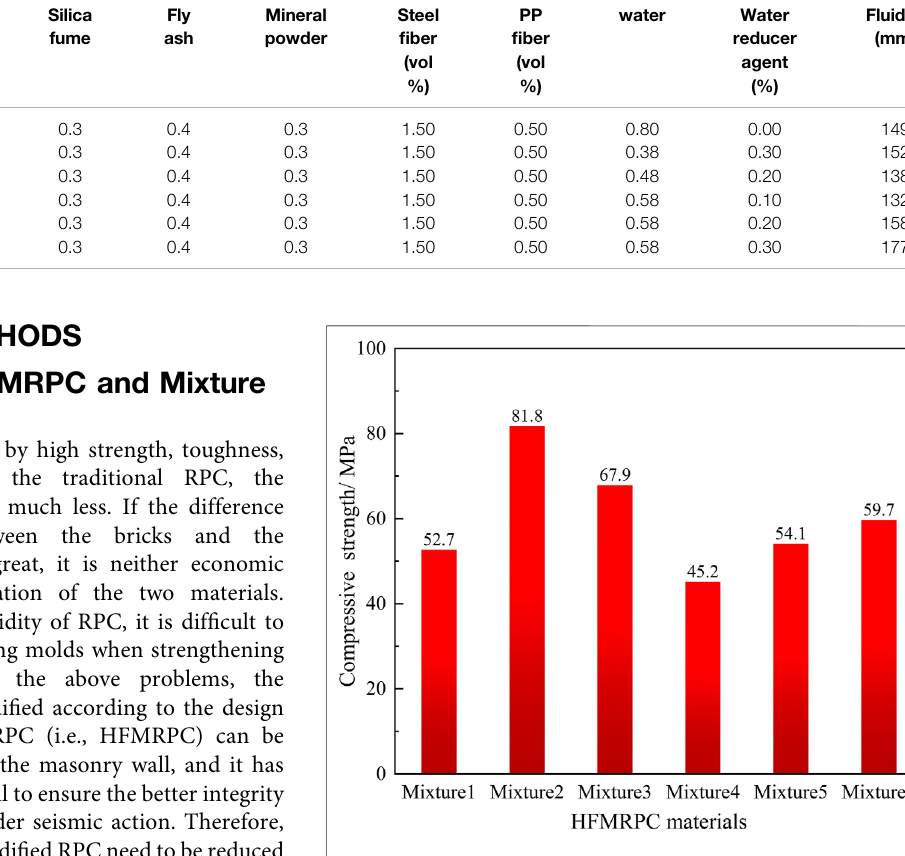
FIGURE 1 | Compressive strength of the HFMRPC materials with various mix